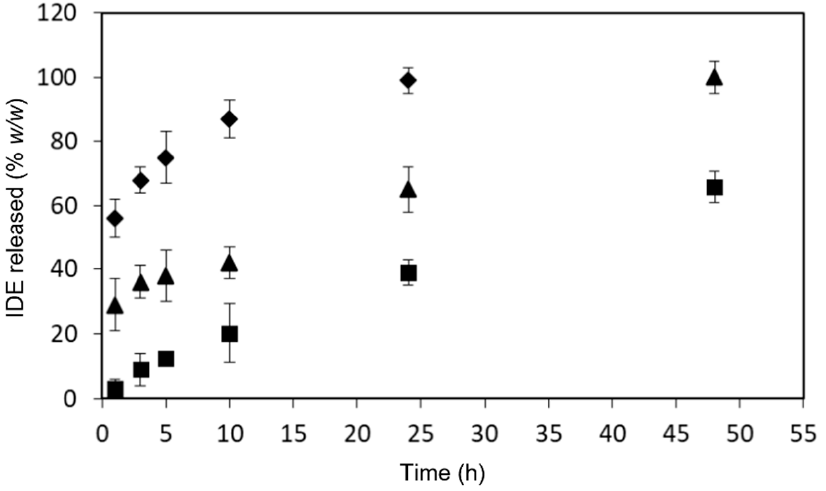
Figure 4. In vitro release profiles of IDE from NP formulations in PBS (pH 7.4), at 37.0 ± 0.5 °C. ∎ non-overloaded CS NPs; ▲ overloaded CS NPs-PC and ◆ overloaded CS NPs-PA.